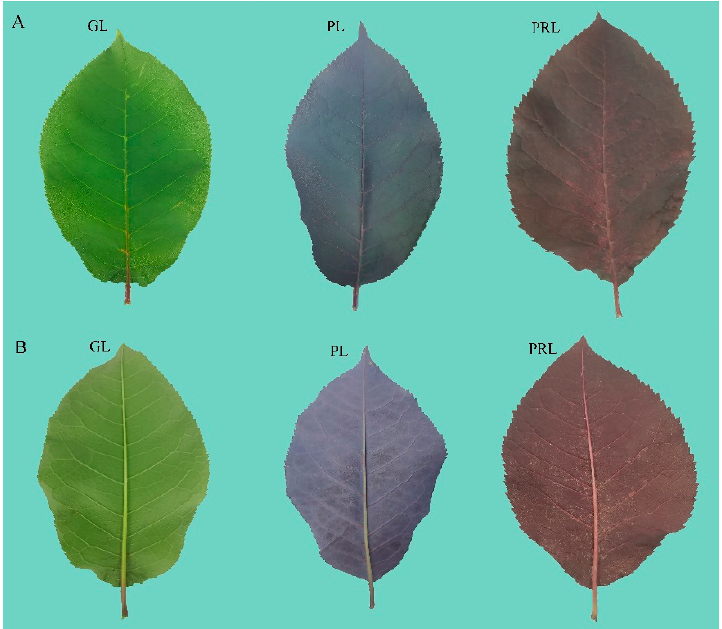
Figure 1. Phenotypes of P. virginiana green (GL), purple (RL) and purple-red (PRL) leaf sides on the adaxial ( A ) and abaxial ( B